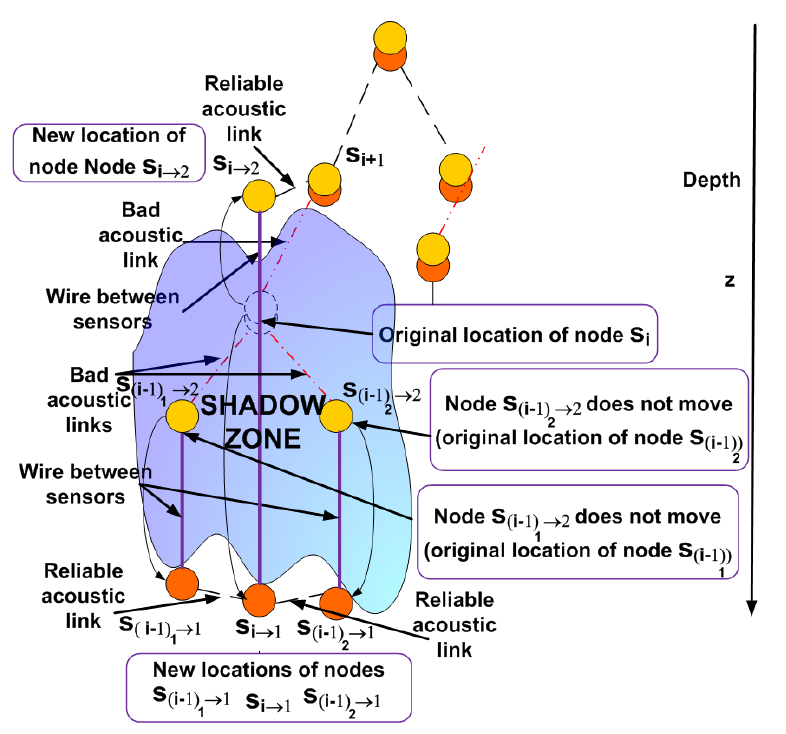
Figure 5. Scenario in the 3D UWSN with a shadow zone (Case